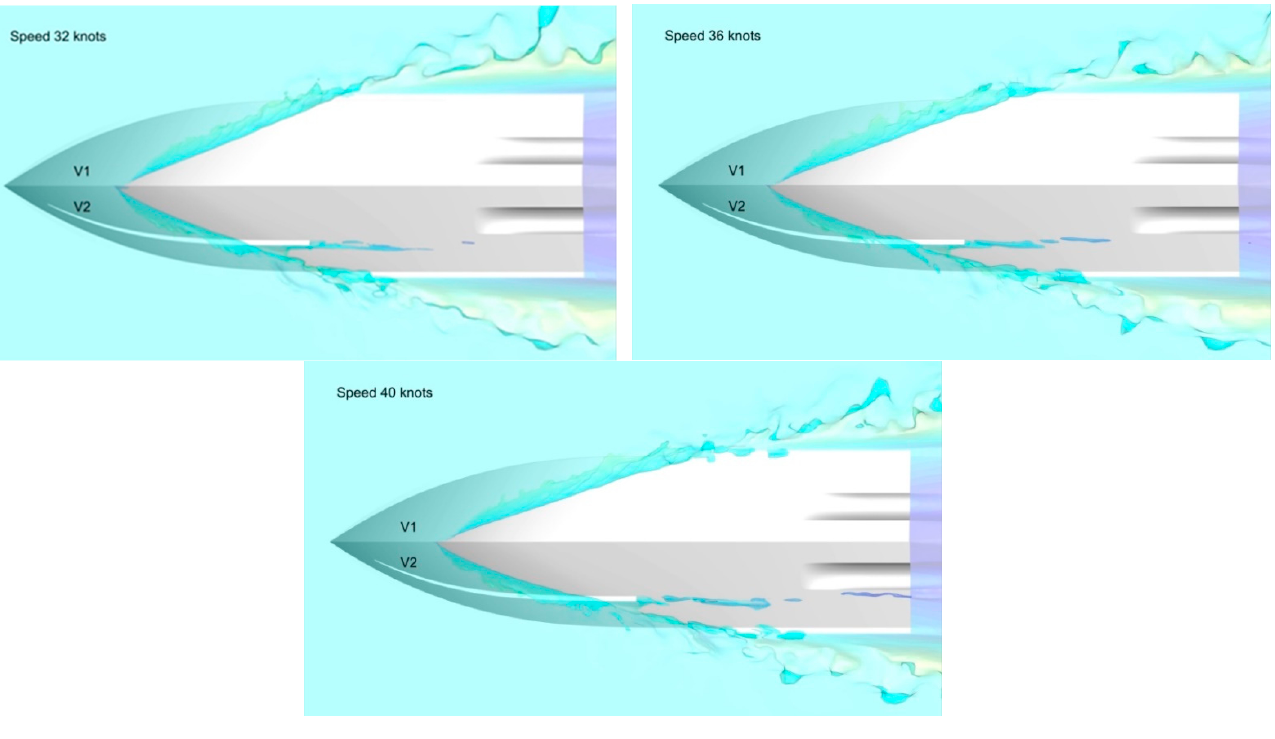
Table 16. Relative difference of global quantities: V4 vs V7.